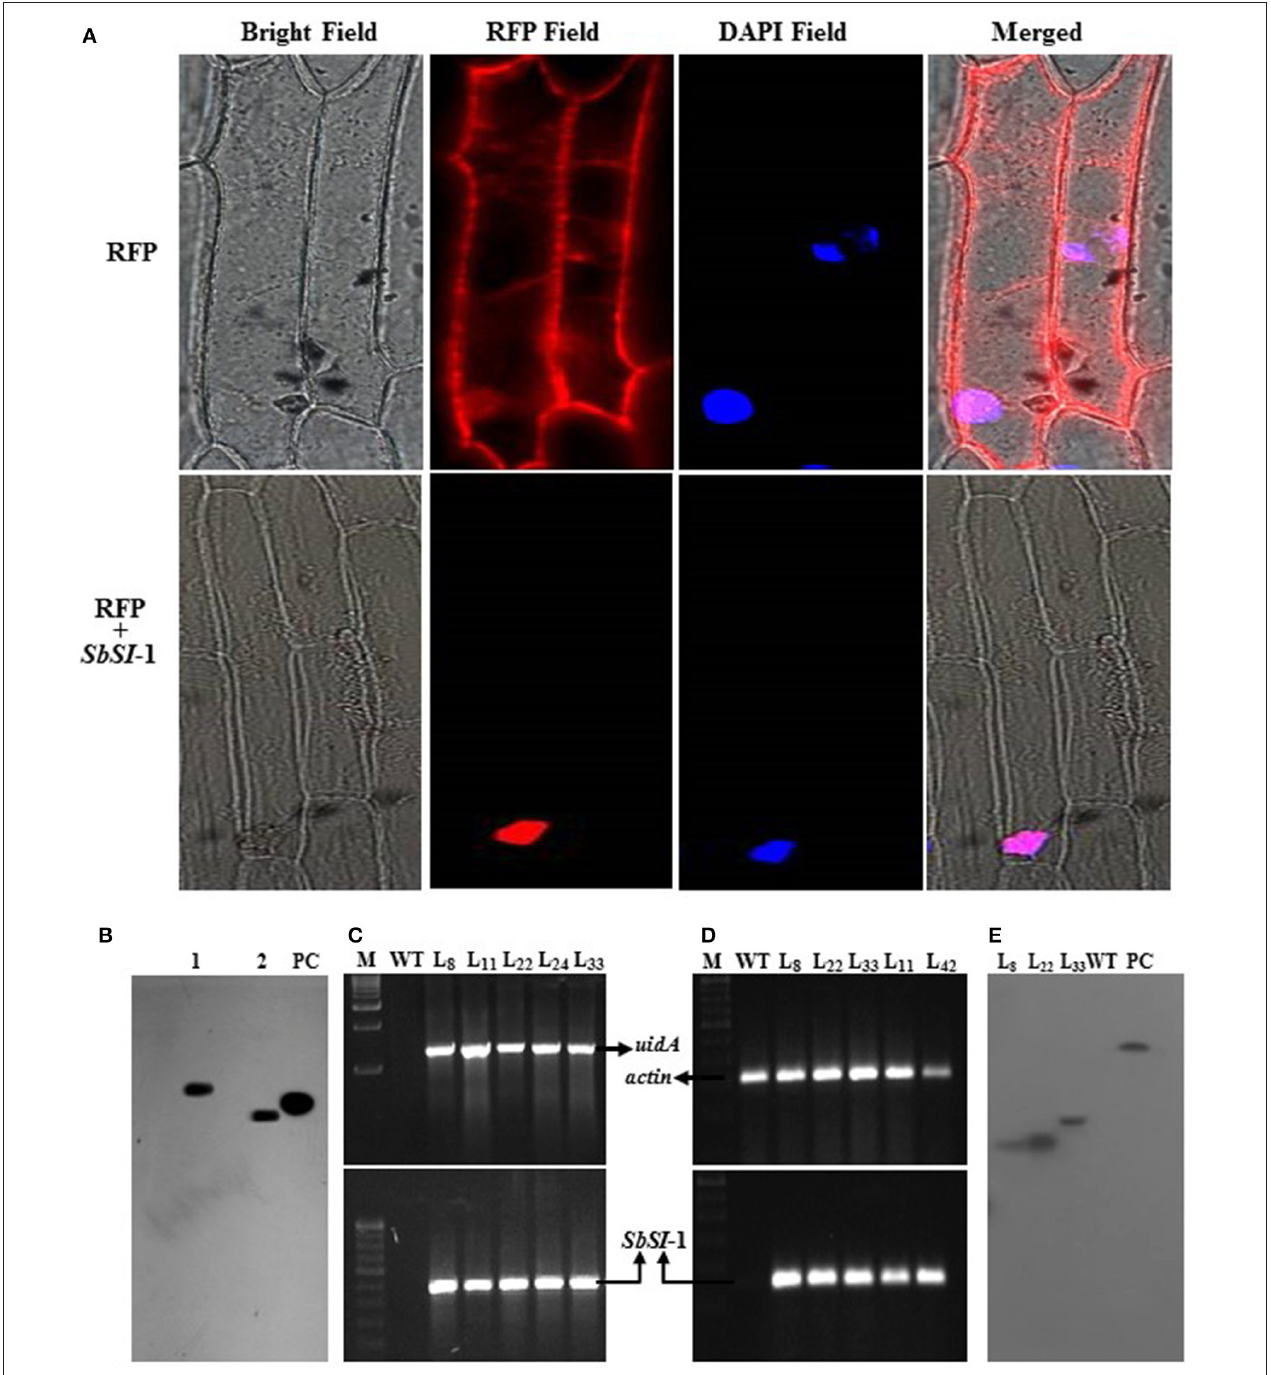
FIGURE 1 | Subcellular localization of SbSI-1 protein, homolog determination and molecular analysis of transgenic tobacco. Transient expression of RFP alone and RFP:SbSI-1 translational fusion protein in onion epidermal cells (A) , determination of homologs of SbSI -1 in S. brachiata by southern blot analysis (B) , PCR confirmation of transgenic tobacco by uid A and SbSI -1 gene amplification (C) , semi-quantitative RT-PCR transgene-expression in transgenic tobacco using actin as an internal control (D) , and determination of transgene integration in tobacco by southern blot analysis (E) . The lane 1–2 are samples digested with Eco R 1 and Xho 1 respectively, PC is positive ( SbSI -1 PCR product of ORF region) control, M is DNA ladder, WT-wild type plant/negative control and L X are transgenic tobacco lines.